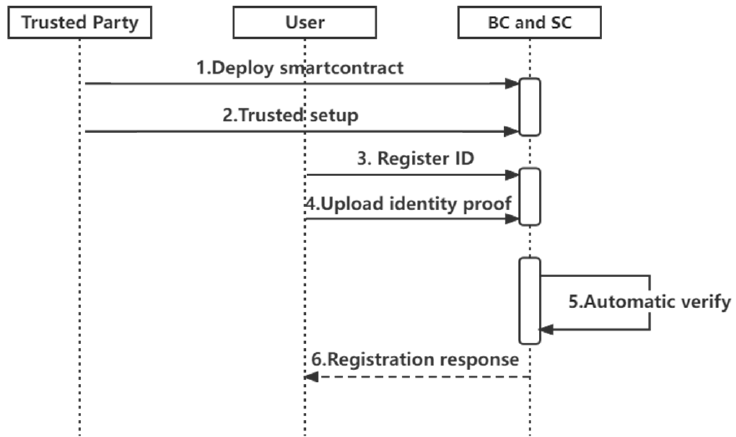
Figure 4. Registration sequence